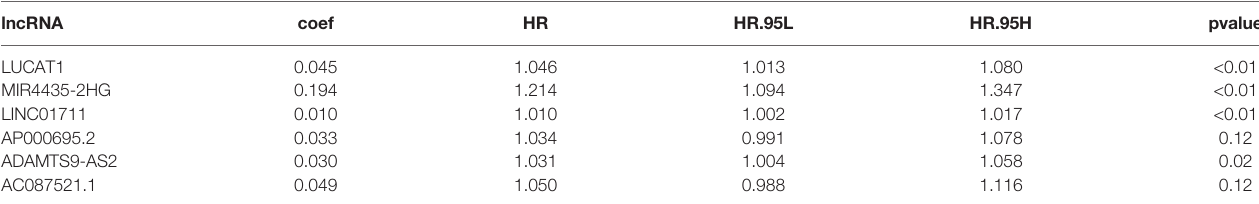
risk score and clinical stage have the greatest impact on 1-, 3-, and 5-year survival in patients with digestive system pan-cancer ( Figure 6 ). The C-index of the prognostic model was 0.713 (95% CI: 0.698-0.728). The risk scores increased with clinical stage, indicating that this prognostic model is signi fi cantly associated with the progression of pan-cancer of the digestive system ( Table 2 ).